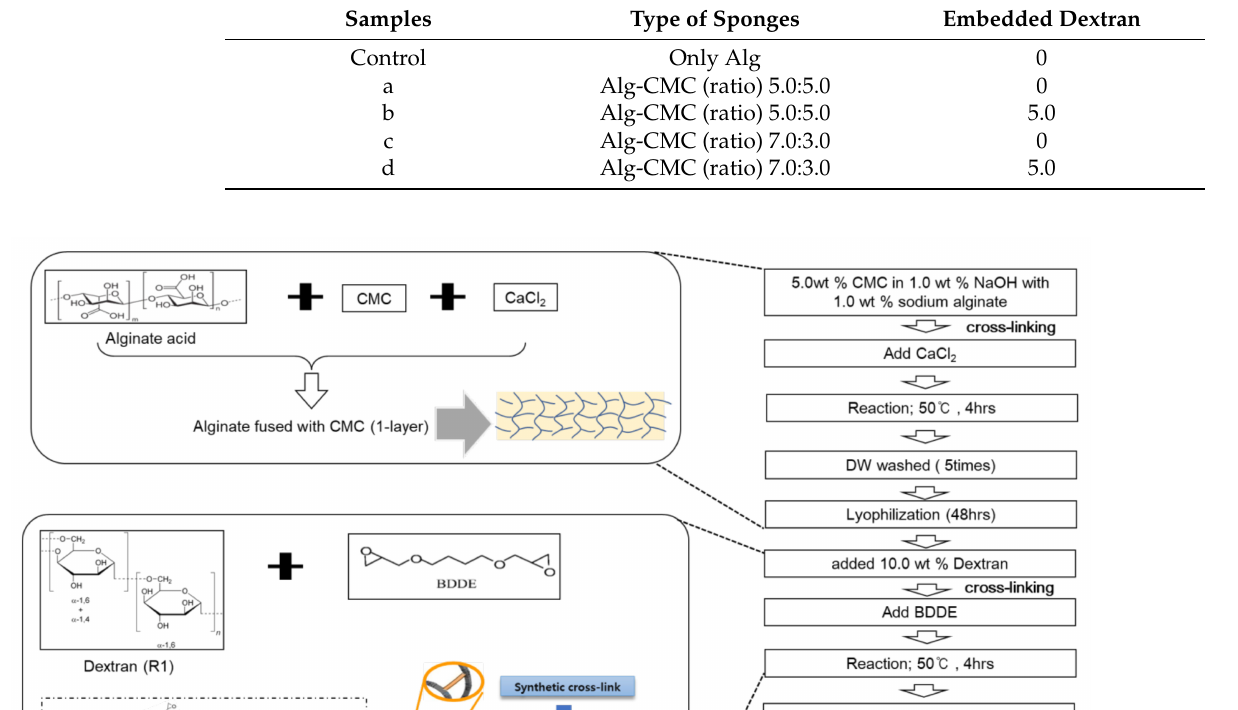
Table 1. Processing conditions for fabrication of Alg-CMC hybrid dextran double-layer superab- sorbent sponges (ACDSs).